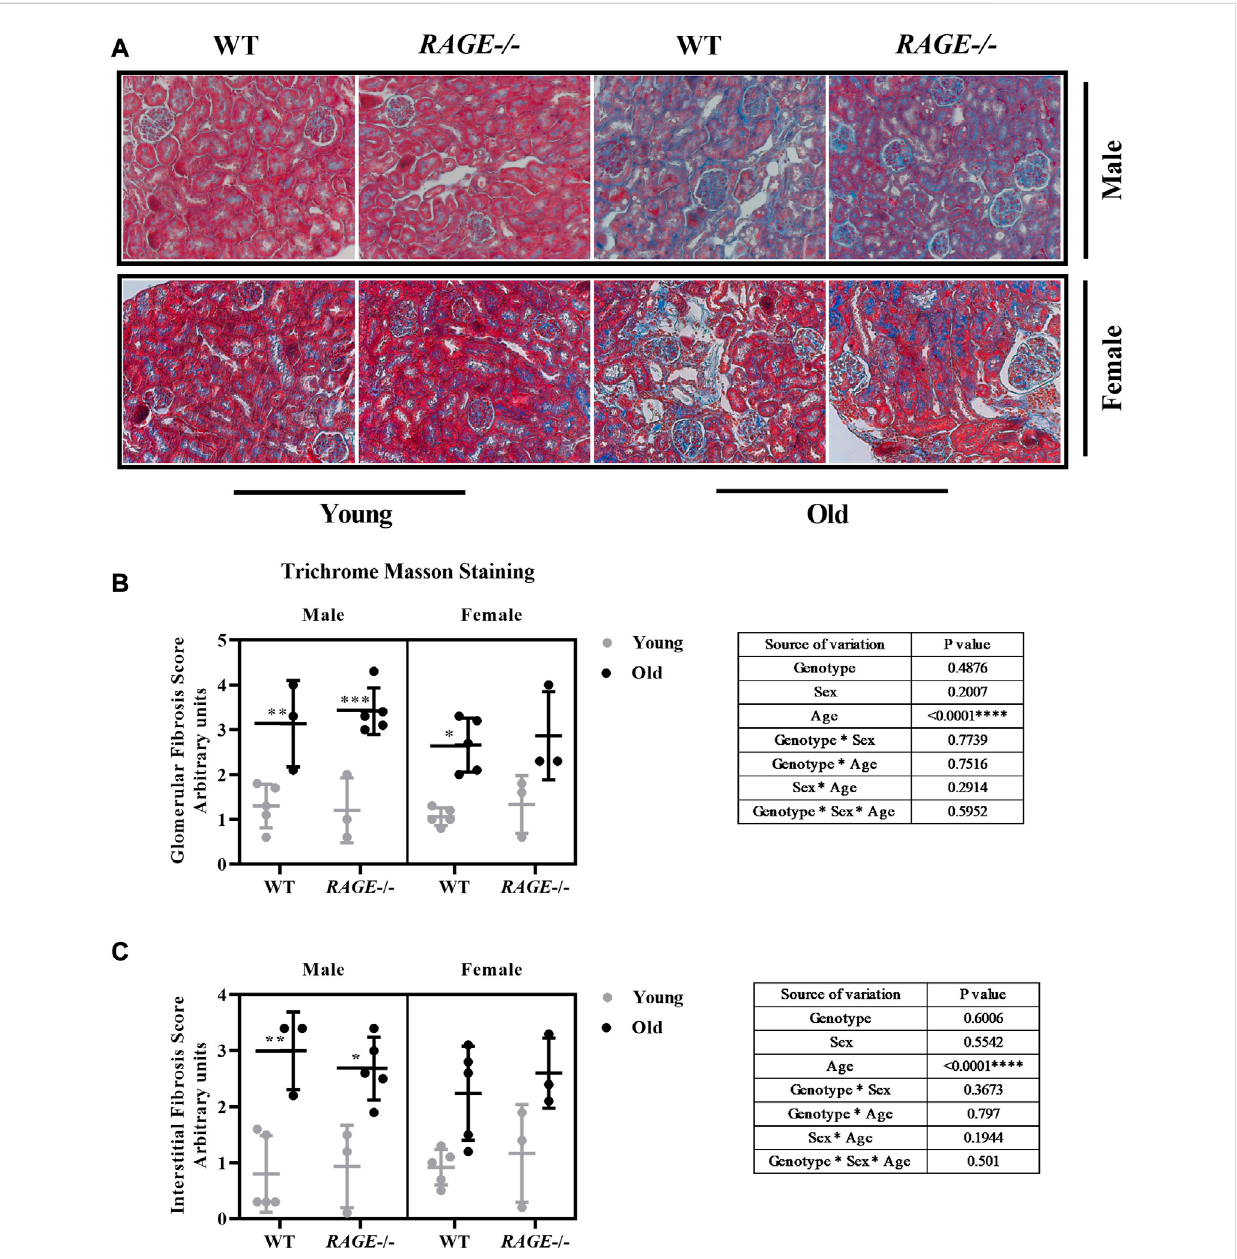
FIGURE 4 Renal fi brosis score assessment through Masson ’ s trichome staining: (A) representative images of Masson ’ s trichome staining of kidney sections from the indicated genotypes. Blue area indicates elevated fi brosis, (B) quanti fi cation of renal glomerular fi brosis, and (C) tubular/interstitial fi brosis scores. Signi fi cance and interaction was calculated by three-way ANOVA with genotype (wild type vs. RAGE − / − , sex (male vs. female), and age (young vs. old)asthreefactors(shownastableinsert).Sidakmultiplecomparisonstestswereperformedforintergroupsigni fi cance(shownabovebars).Young ( < 30 weeks) and old ( > 70 weeks) male and female mice ( n = 3 – 7) were used in the experiment. Images were taken under ×200 magni fi cation. Data are shown as mean ± SD; p- value: 0.05*, 0.01**, 0.001***, and